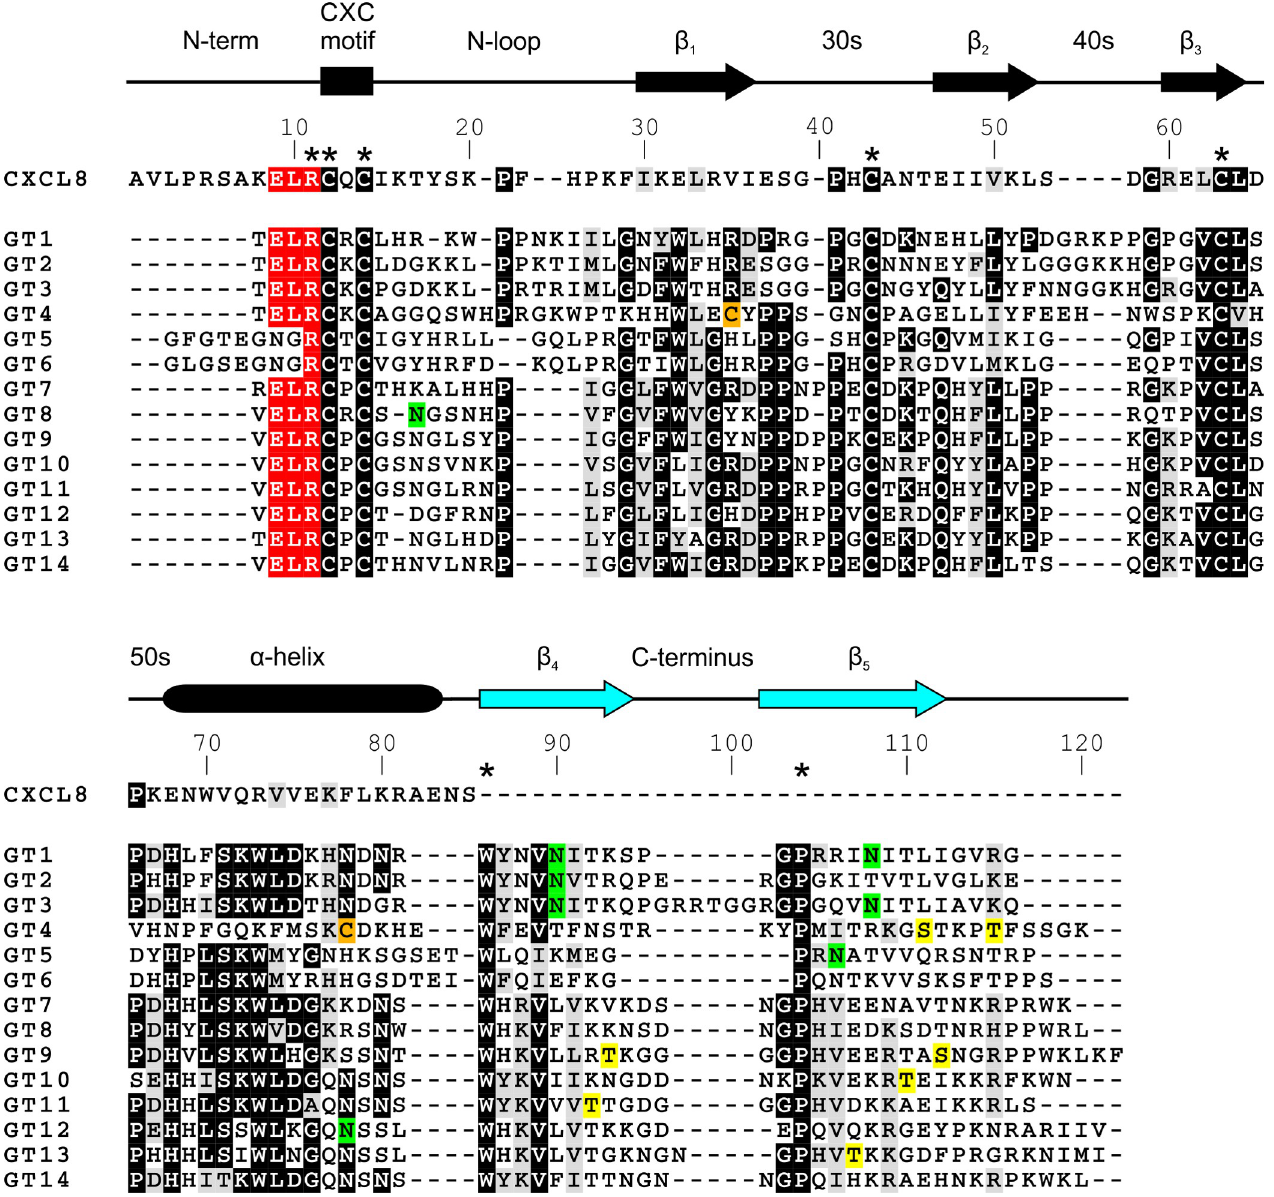
Fig 1. Sequence alignments of the endogenous human chemokine CXCL8 and the 14 highly divergent genotypes of the HCMV-encoded UL146 chemokine. Alignment generated with ClustalW 2.1 and adapted to illustrate differences in secondary structure. White on black illustrates identical residues, and black on grey similar residues. Important differences are color coded. The ELR motif is marked white on red and residues 100% conserved in UL146 are marked with a star ( � ). Genotypes 5 and 6 are shown with the longer N-terminus predicted by the SignalP 4.1 server [16]. Predicted glycosylation sites are marked black on green (N-glycosylation) and black on yellow (O-glycosylation) based on the NetNGlyc 1.0 [17] and NetOGlyc 4.0 [18] server predictions (threshold = 0.5). The two additional cysteine residues in the vCXCL1 GT4 sequence (suggesting a third disulfide bond) are marked black on orange. The secondary structures of the chemokines are shown above the sequences as determined by NMR and X-ray structures for CXCL8 [23–25]and determined by Rosetta modelling for vCXCL1 GT1–GT14 . The proposed fourth and fifth β -strands unique to several vCXCL1 genotypes of the UL146 encoded chemokines have been marked by light blue (for the exact location of the α -helix and the β -strands for a particular UL146 genotype see S1 Fig). and 37% acetonitrile respectively (Fig 2B) that were not present in the medium of cells trans- fected with the empty expression vector. MALDI-TOF analysis of the corresponding isolated fractions revealed pure samples with three peaks at 12188–12791 Da for vCXCL1 (Fig 2C). GT5